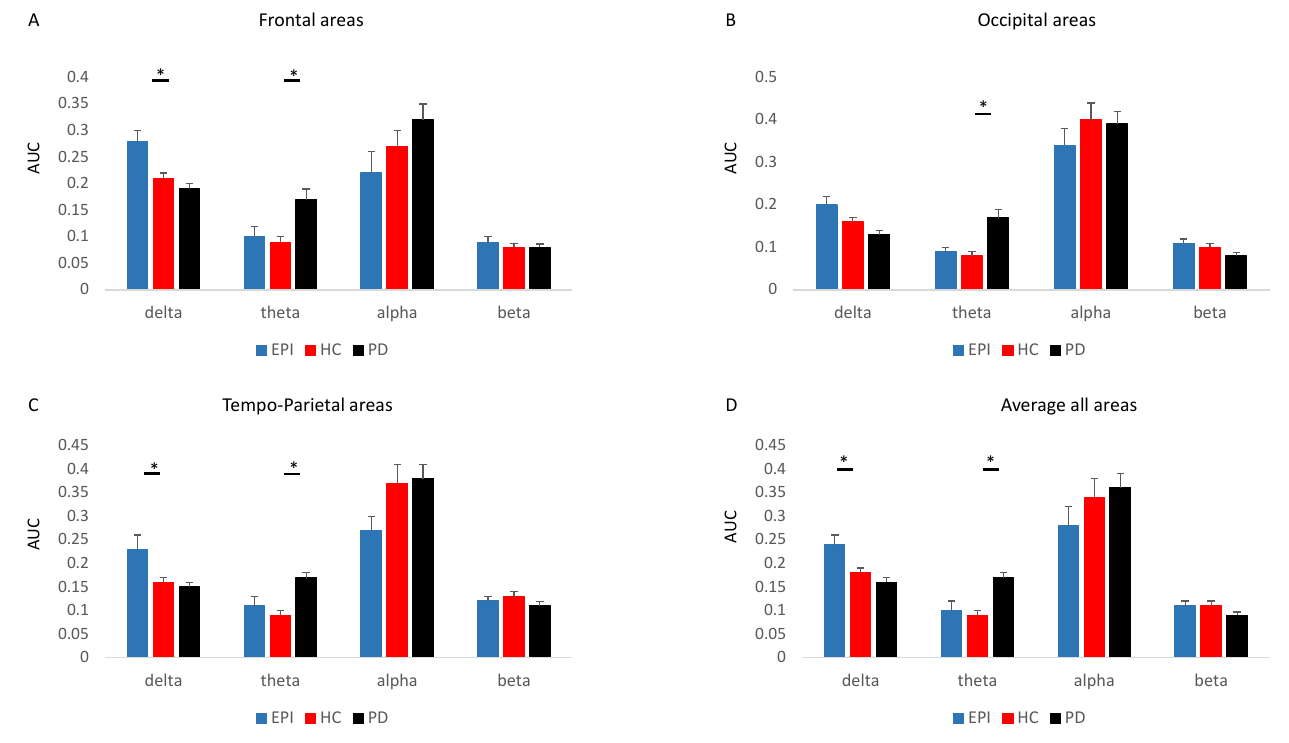
Figure 2. The area under the curve (AUC) of each of the waves for the spectrums in ( A ) Frontal areas, ( B ) Occipital areas, ( C ) Tempo-Parietal areas, and ( D ) Average over all areas. * significant